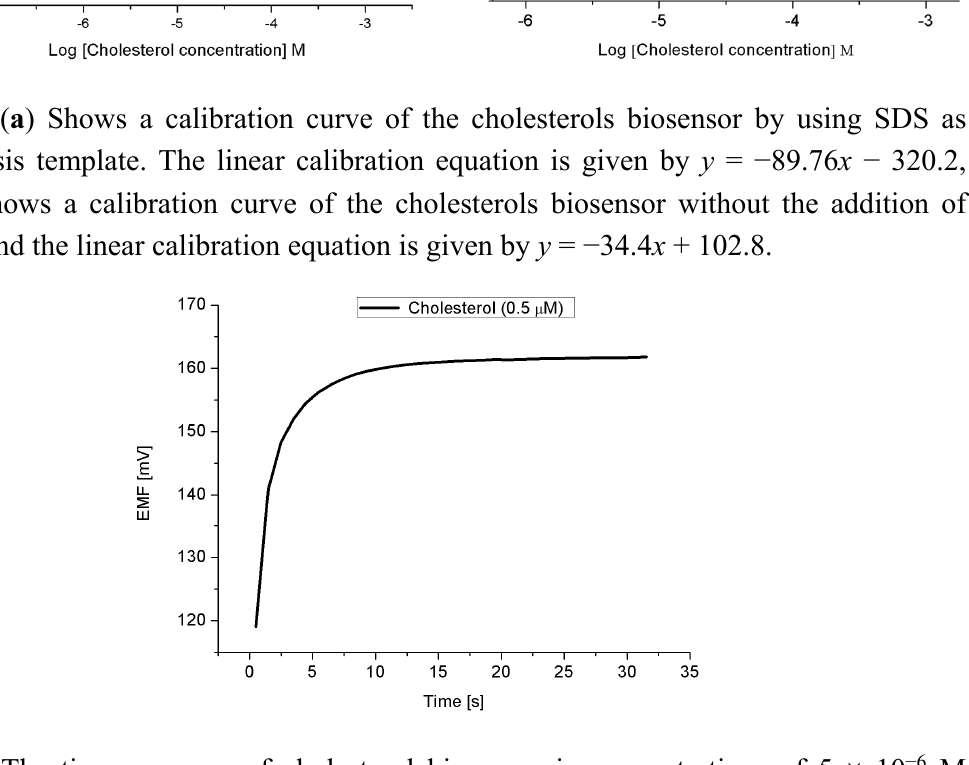
Figure 6. The time response of cholesterol biosensor in concentrations of 5 × 10 − 6 M of Cholesterol.